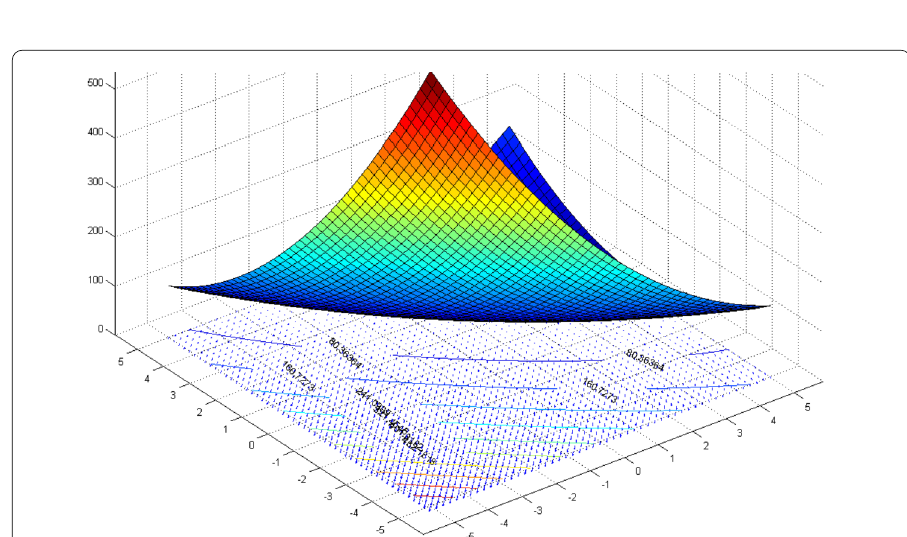
Figure 2 The graph of Booth function with contour lines and its gradients